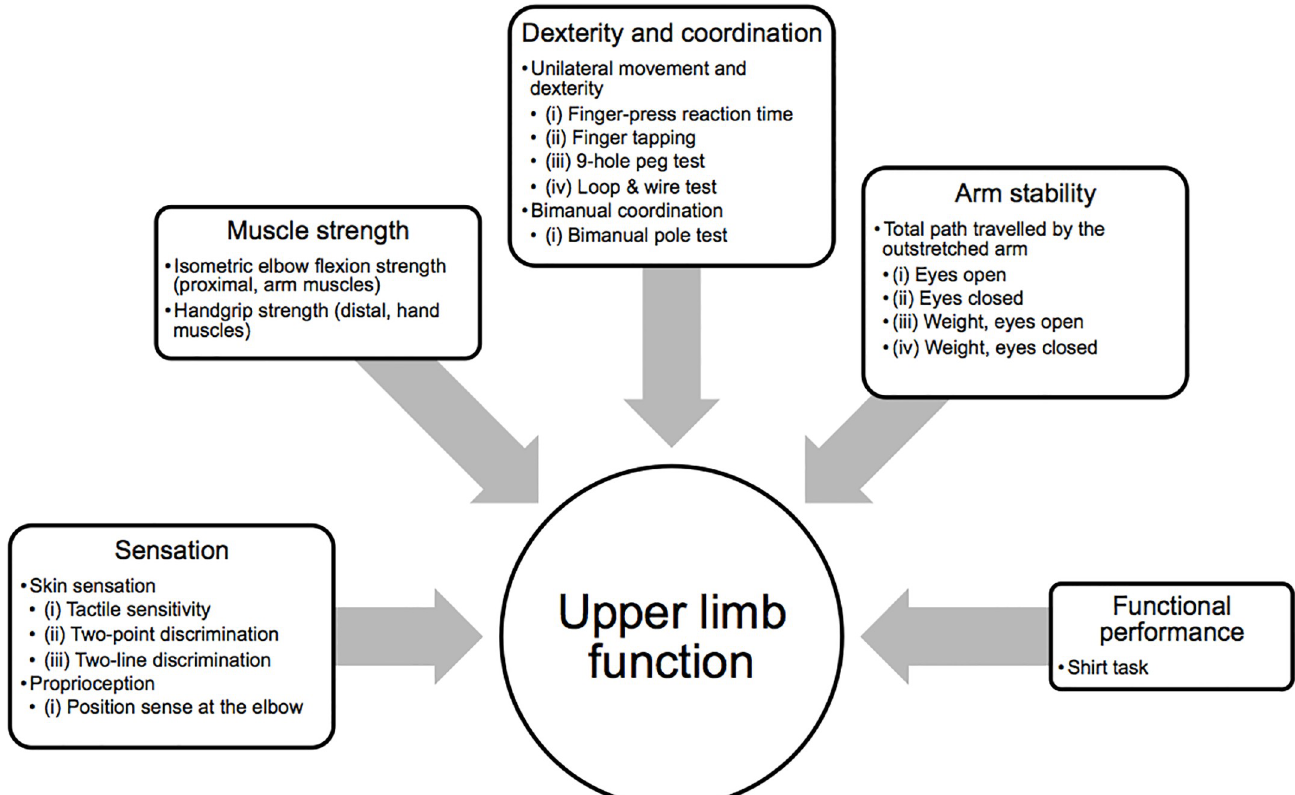
Fig 1. Physiological domains model. Contributory physiological domains critical for upper limb